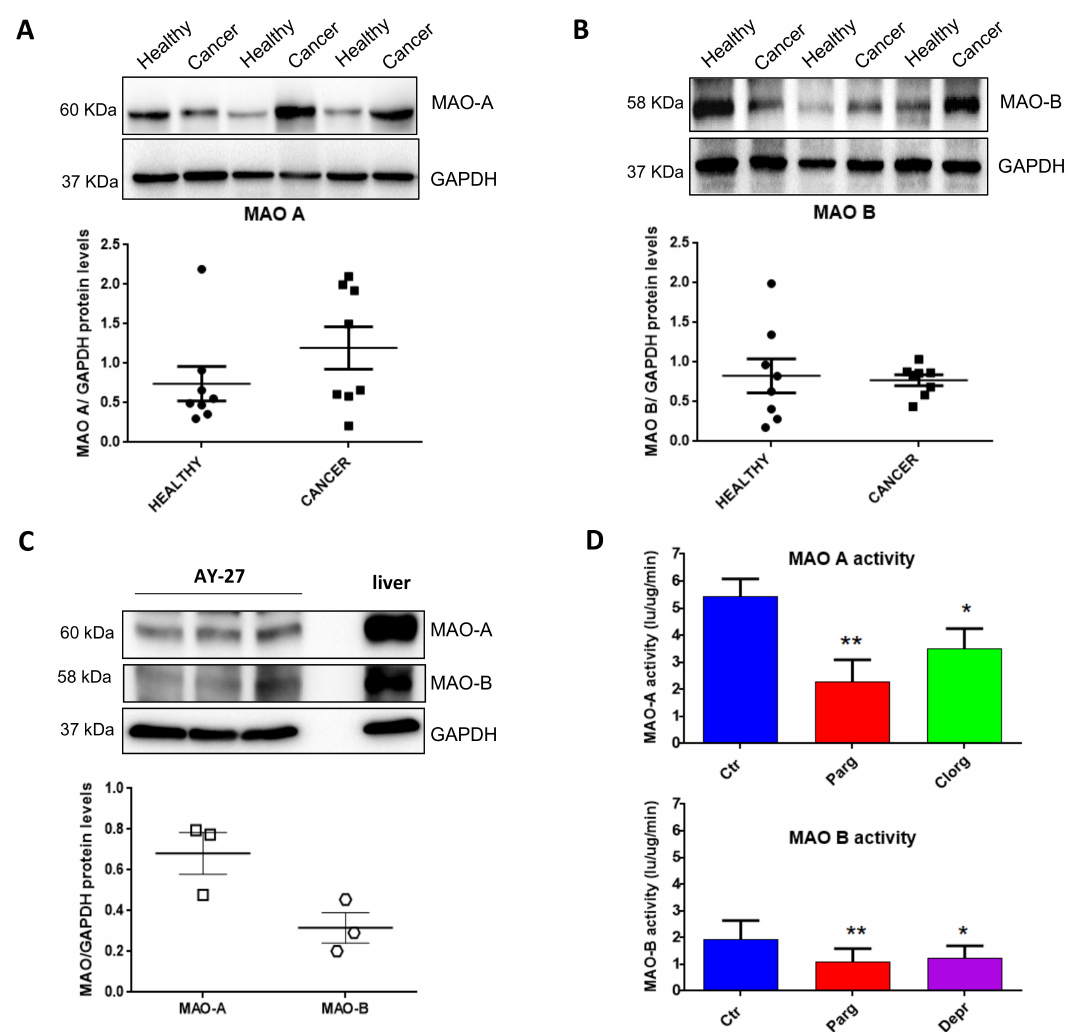
Figure 1. Expression of MAOs in human bladder tumors and AY27 cells. ( A , B ) Protein expression of MAO-A and MAO-B in human bladder tissues (health vs. cancer), N = 8. ( C ) Protein expression of MAO-A and MAO-B in AY27 cells, N = 3. ( D ) Quantification of MAO-A and MAO-B activities in AY27 cells in control conditions (Ctr) or after inhibitor treatment with pargyline 10 − 5 M, clorgyline 10 − 6 M or deprenyl 10 − 6 M (N = 5). * p < 0.05, ** p < 0.01 compared with Ctr cells. All the values are expressed as mean ±